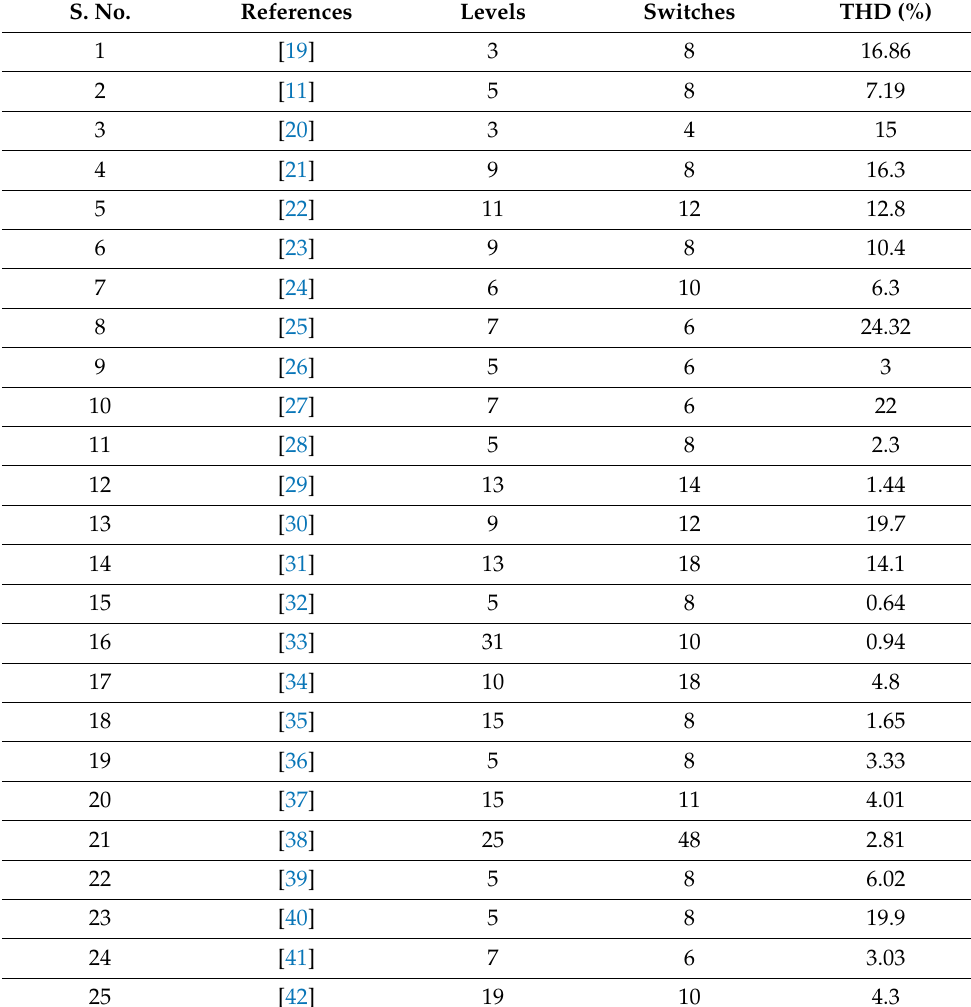
Table 3. Methods for inverter level